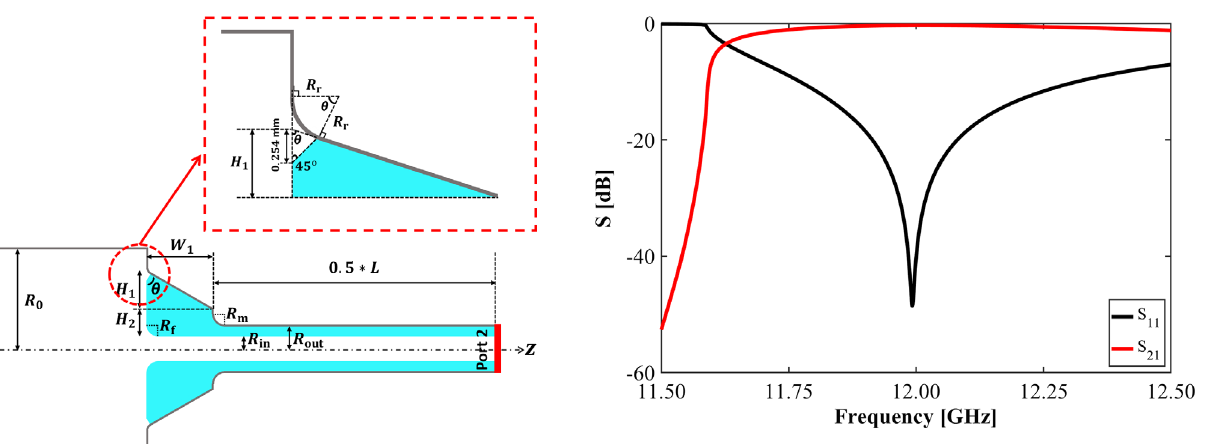
mm.FIG. 4. Longitudinal cross section of a circular waveguide, a compact dielectric matching section, and a DLA